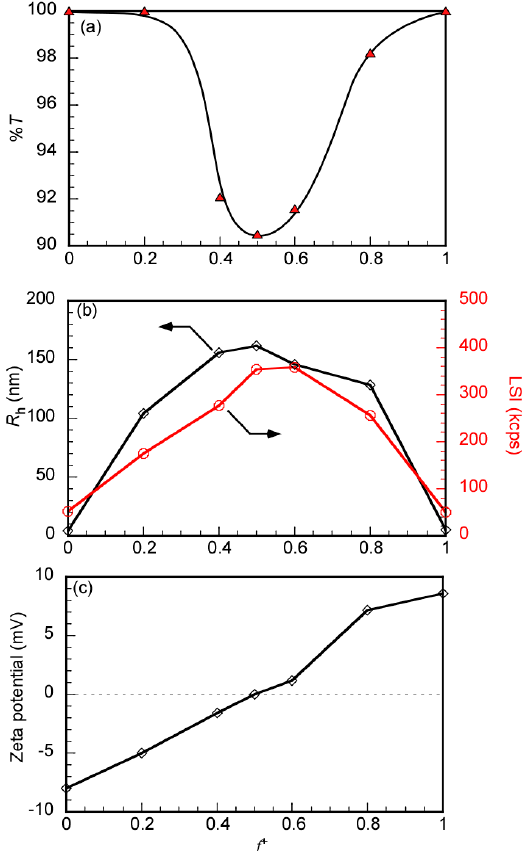
Figure 3. ( a ) Percentage transmittance (% T ), ( b ) hydrodynamic radius ( R h , black diamonds), light scattering intensity (LSI, red circles), and ( c ) the zeta potential of 0.1 M NaCl aqueous PSBP/CTAB complex solutions as a function of the mixing ratio ( f + ) at 25 °C.